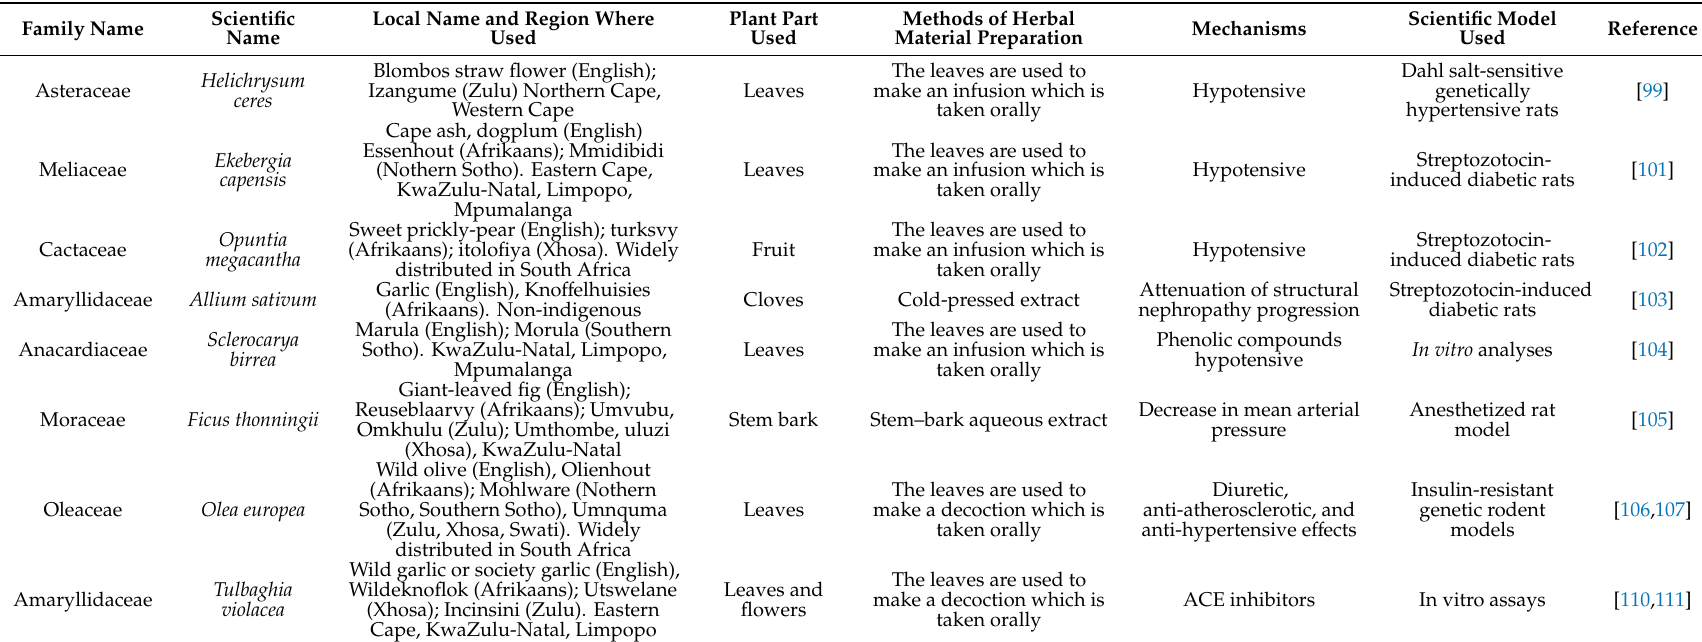
Table 3. Plants used in the management of cardiovascular diseases in South